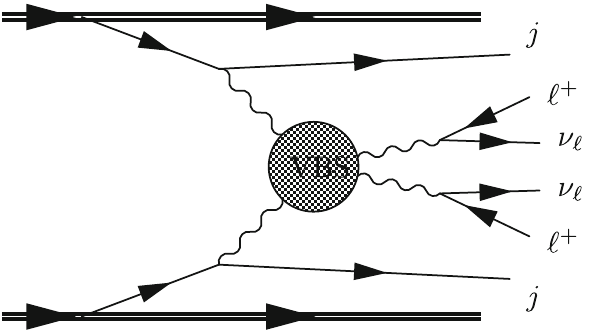
Fig. 1 Vector boson scattering contribution to the process pp → W + W + jjX [ − 960 , 960] TeV − 4 from 20 . 3 fb − 1 of